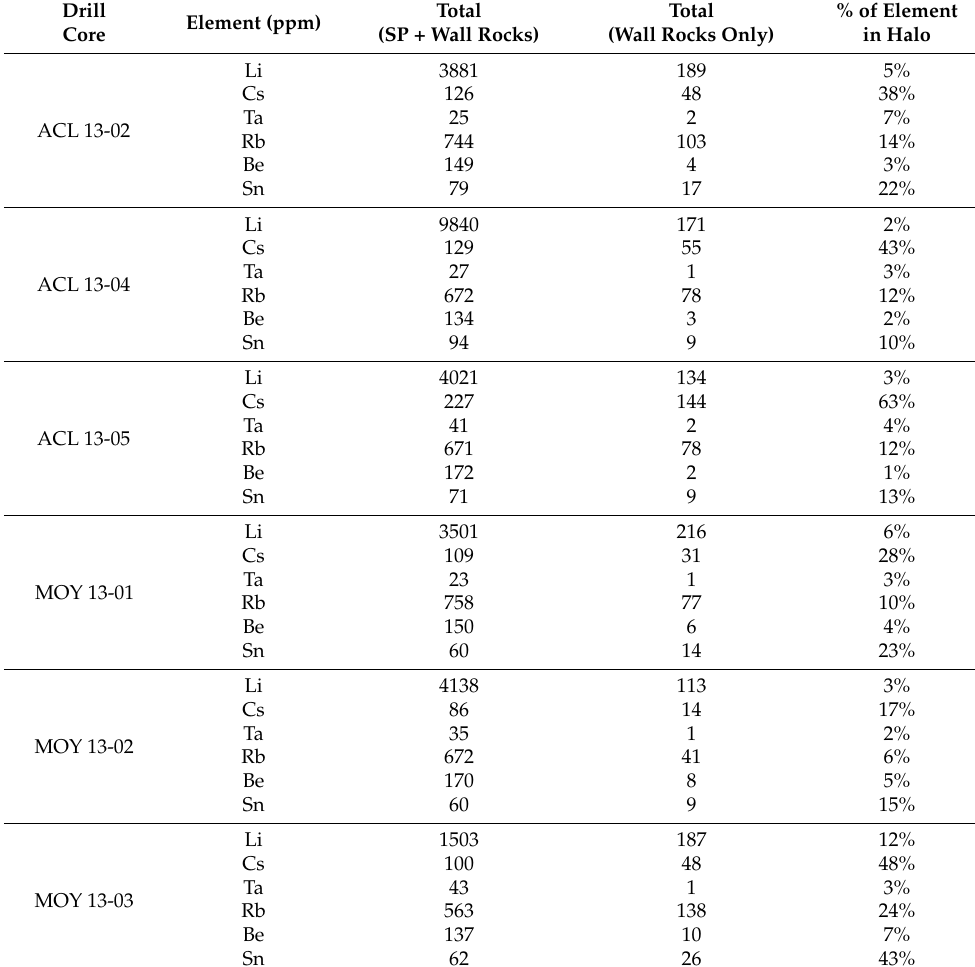
Table 2. Estimated mean concentrations (ppm) of key elements in the exomorphic halos, weighted by drill hole interval